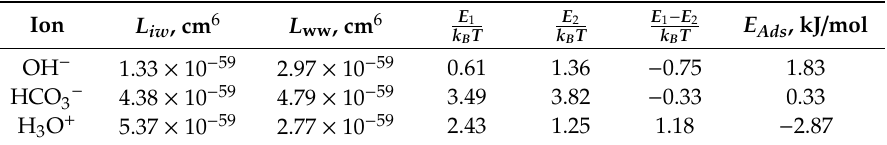
Table 4. London constants L iw and L ww , dimensionless gain of energy of transfer of the ion from the bulk to the air / water surface E 1 / k B T , dimensionless loss of energy of transfer of N w water molecules from the air / water interface to the bulk of the water E 2 / k B T , dimensionless total energy of adsorption of one ion ( E 1 − E 2 ) / k B T and adsorption energy E Ads per mol of ions on the air / water interface for OH − , HCO 3 − and H 3 O +